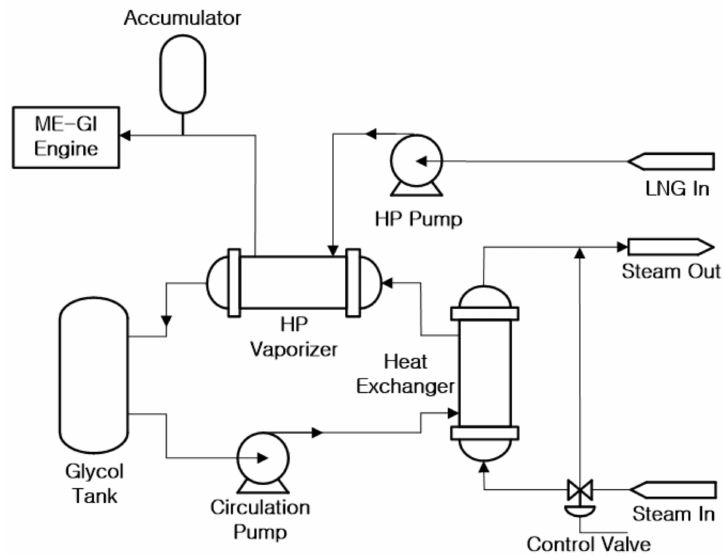
Figure 1. A regasification system for LNG-fueled marine